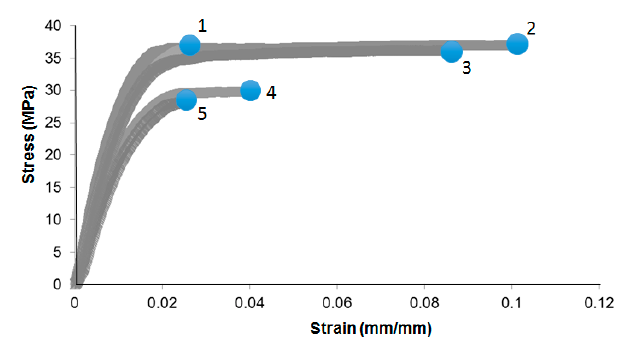
Figure 3. Repeats of engineering stress-strain response of a typical natural fiber reinforced composites (NFRC) sample tested under tensile loading; notice non-repeatability of the material behavior beyond the linear elastic limit, in particular the maximum elongation at the failure point (represented by a circle for each curve), as well the corresponding tensile strength.